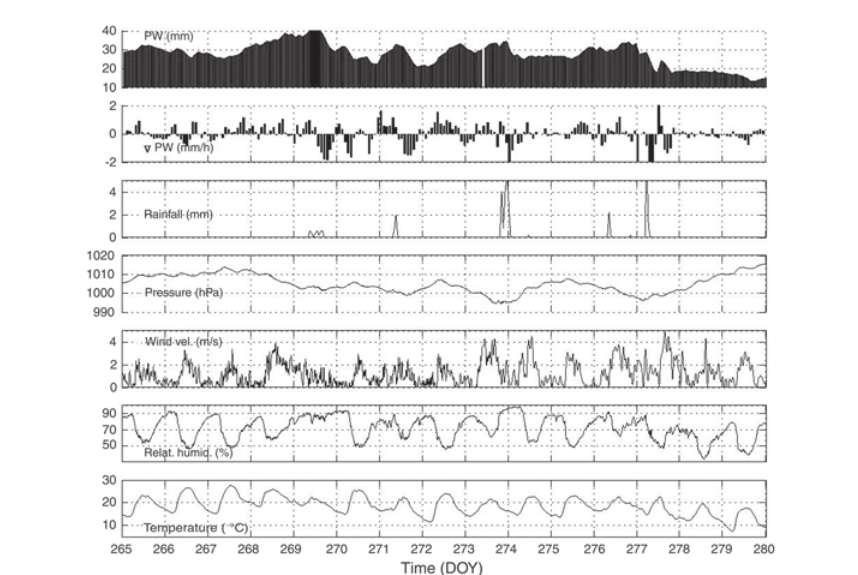
Fig. 2. Precipitable Water (PW, mm) and PW curve derivative coefficient sign ( ∇ PW, mm/h) for Padua; barome- tric pressure (hPa); wind velocity (m/s); relative humidity (%) and air temperature at 2 m ( ° C) for Verona versus time for period of DOY 265-280, 22 September - 07 October, 1999.